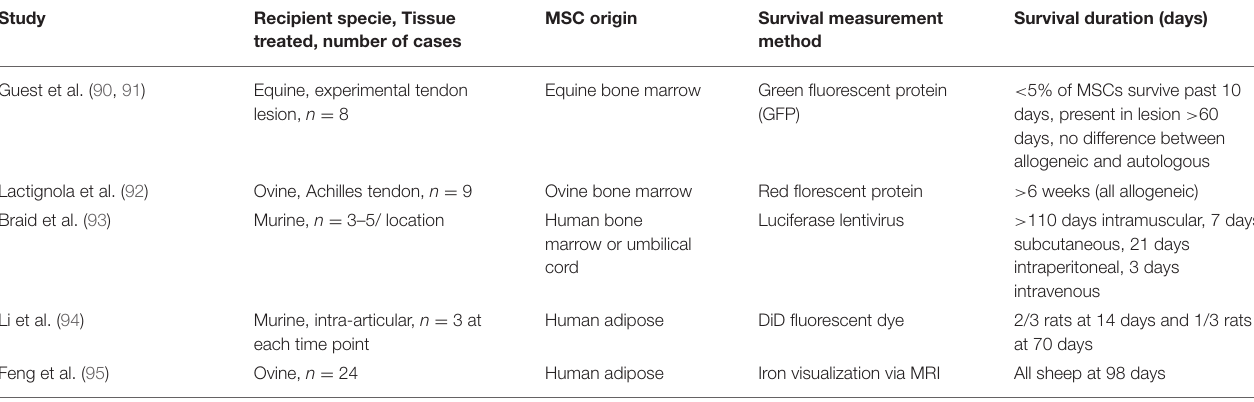
TABLE 1 | Relevant allogeneic MSC survival studies.